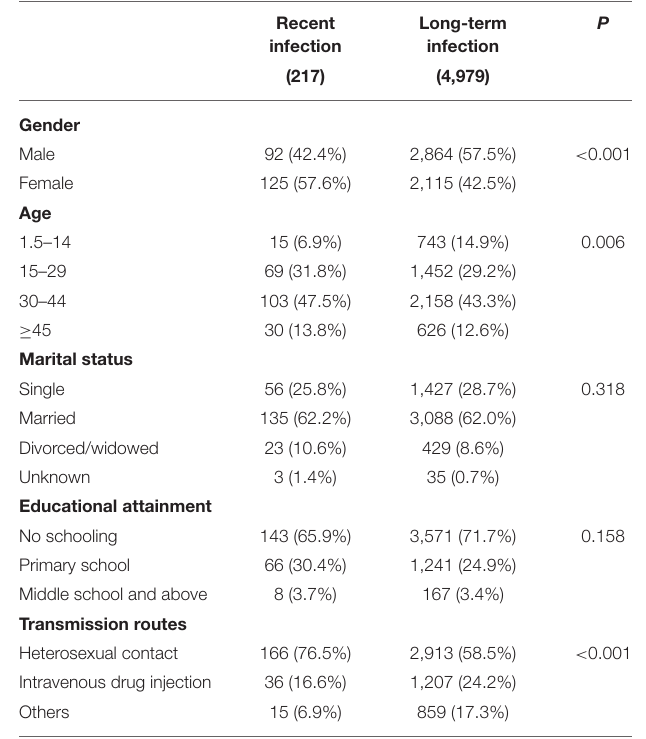
TABLE 1 | Demographic characteristics of included individuals.